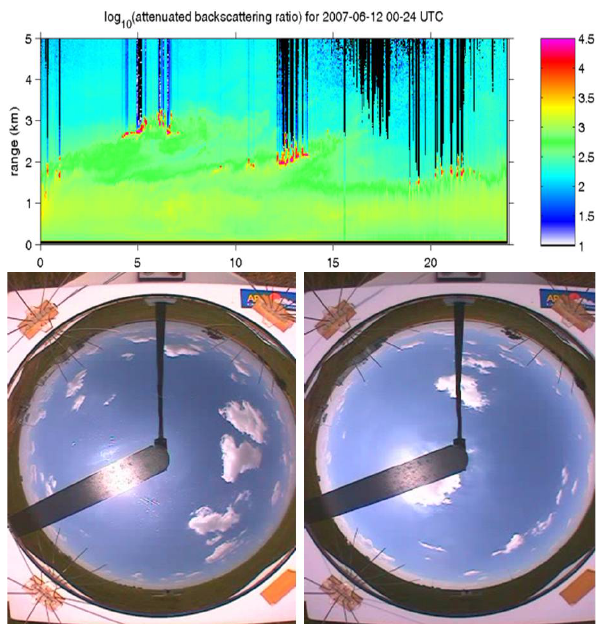
Fig. 3. Two-dimensional images of ground-based micropulse lidar attenuated backscatter (km − 1 sr − 1 ) (top) and hemispherical total sky images (bottom) for 12 June 2007. Top: The horizontal and vertical axes represent time (UTC) and altitude (km), respectively.